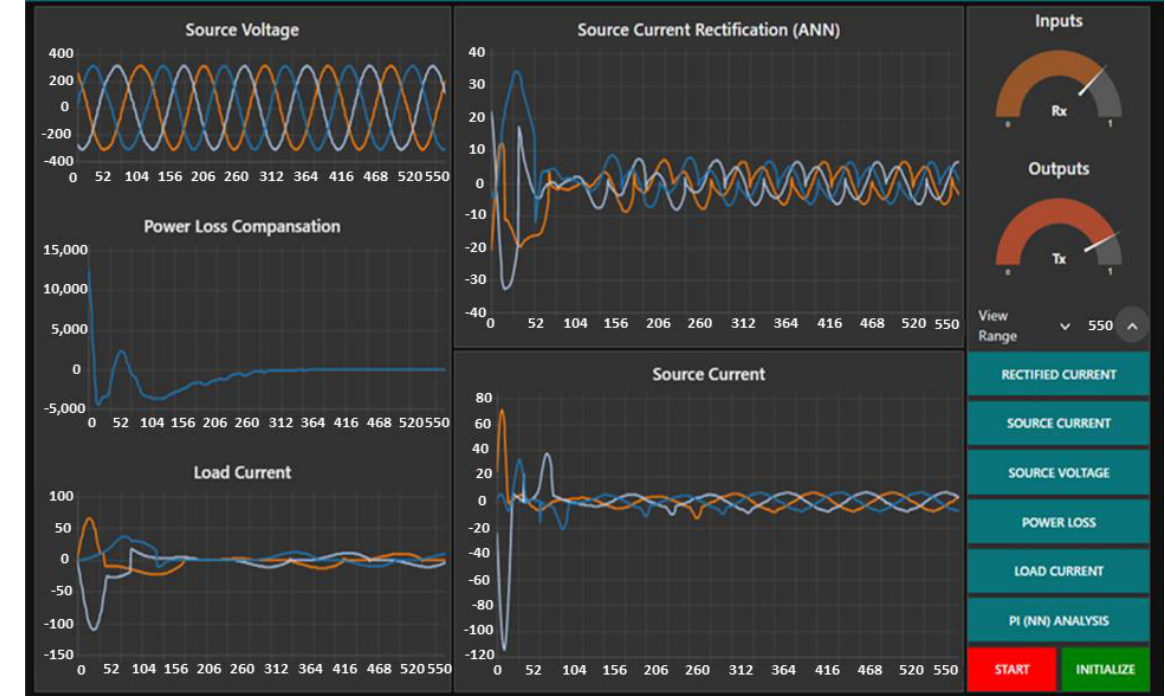
Figure 35. Node-RED Front End Dashboard.